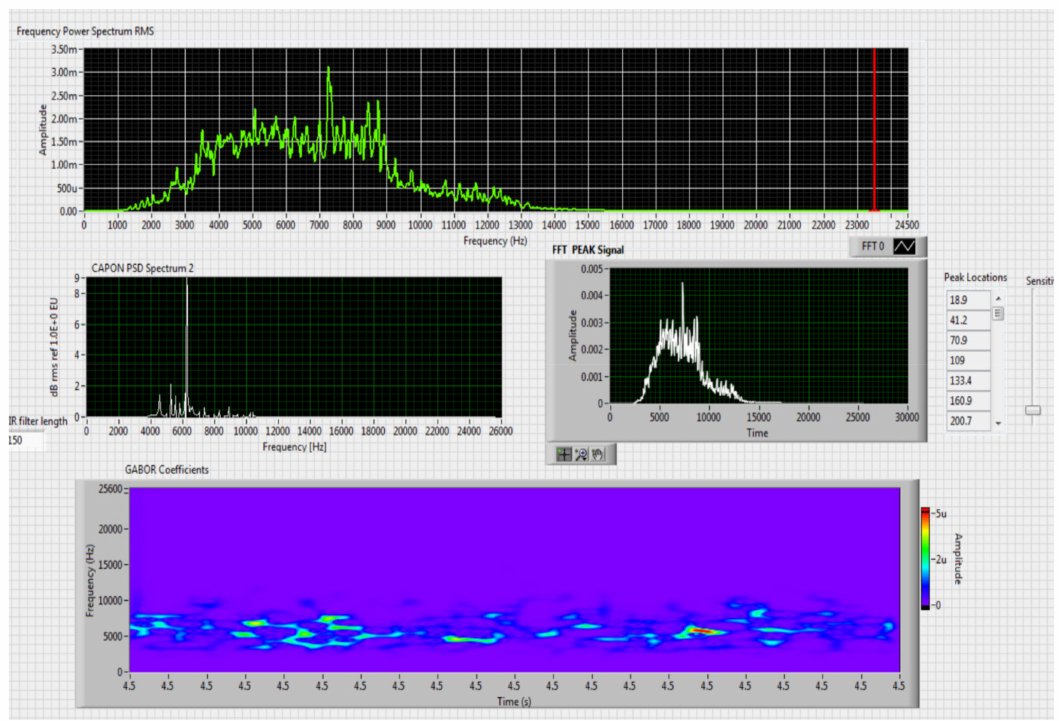
Figure 10. Results obtained for moving distance 50–250 m, altitude 4